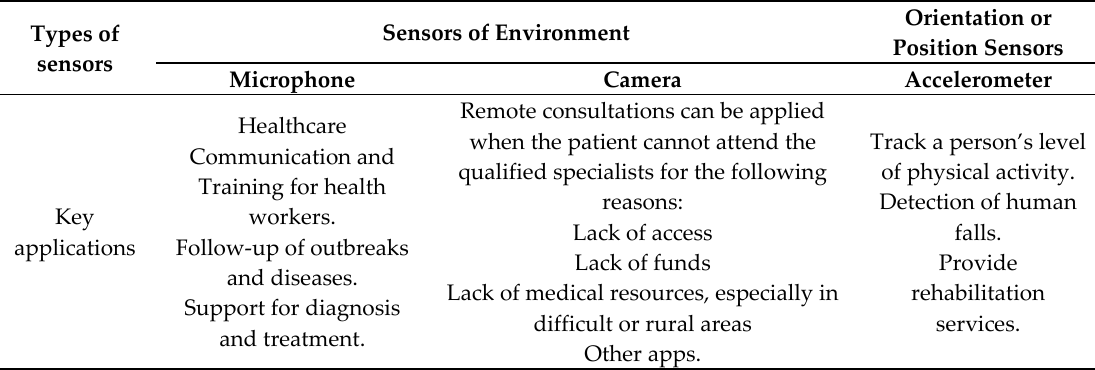
Table 1. Sensors: Types, Environments and Position. Source: Stankevich et al.,